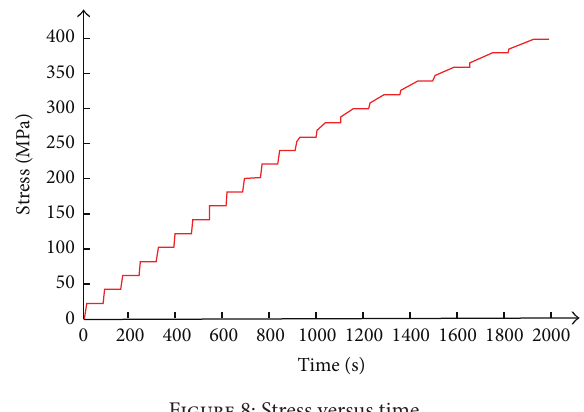
Figure 8: Stress versus